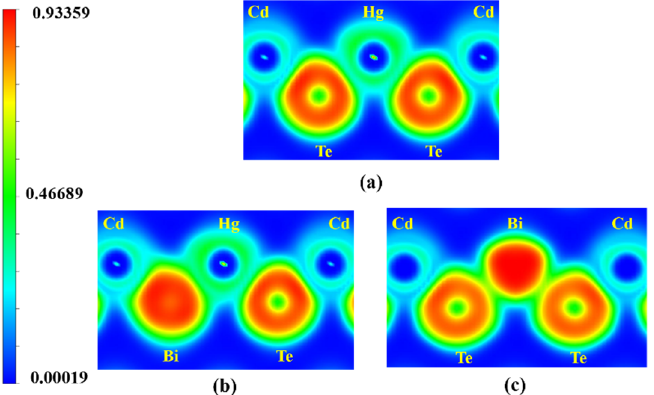
Figure 3. ELF in the (1, 0, − 1) plane for ( a ) undoped Hg 0.75 Cd 0.25 Te, ( b ) the in situ impurity Bi Te in Hg 0.75 Cd 0.25 Te, and ( c ) the in situ impurity Bi Hg in Hg 0.75 Cd 0.25 Te.